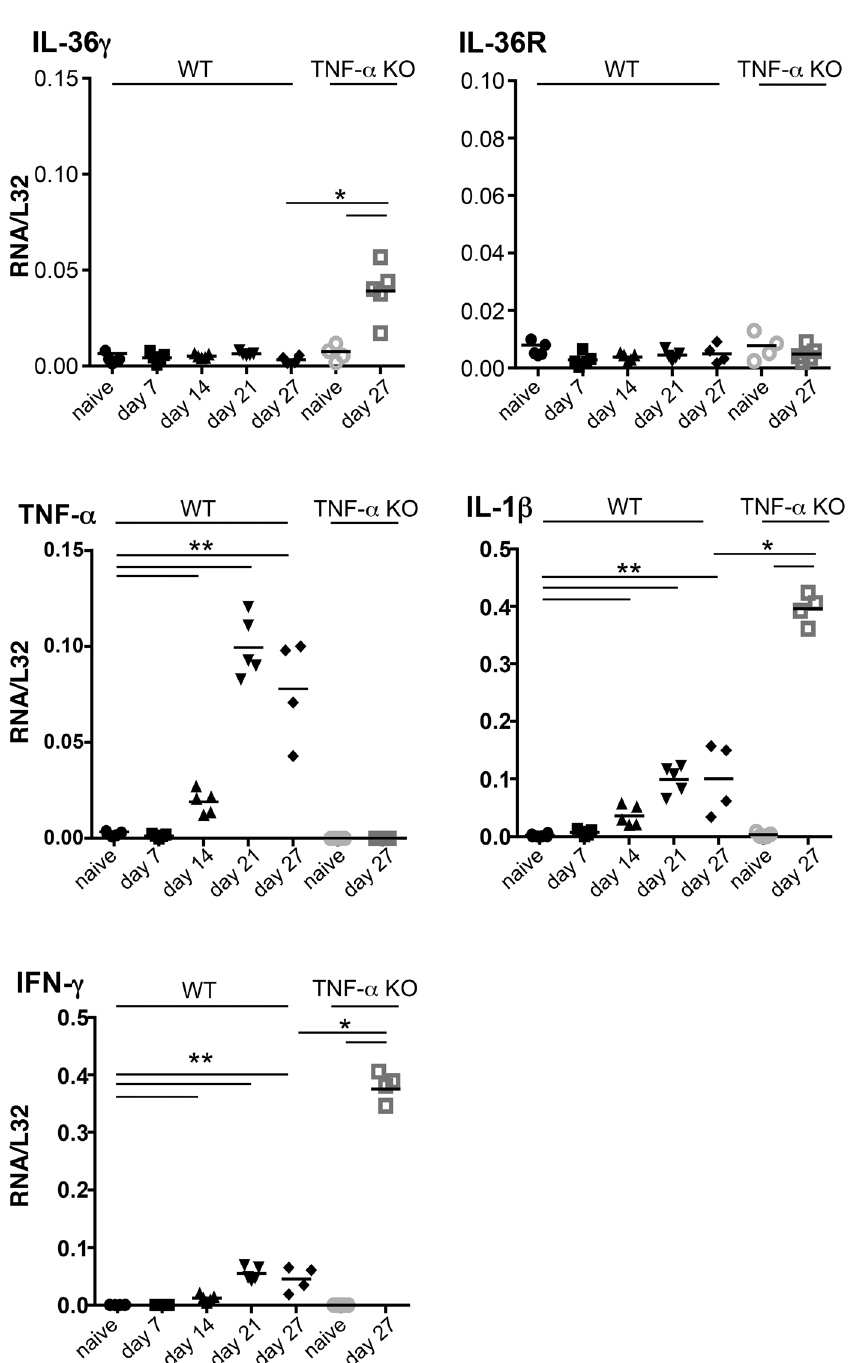
Fig 7. Kinetics of pulmonary cytokine expression after M . tuberculosis infection. Total RNA was prepared from the lungs of na ï ve WT (black symbols) and TNF- α deficient mice (grey symbols) and at days 7, 14, 21 and 27 after M . tuberculosis infection in WT (black symbols) and at day 27 in TNF- α deficient mice (grey symbols). The results represent the levels of Il36g , Il36r , Tnfa , Il1b , and Ifng mRNA determined by RT- qPCR normalized to L32 mRNA (n = 5 per group). * P < 0.05, ** P < 0.01, as assessed by Kruskal-Wallis, followed by Mann-Whitney test (C).